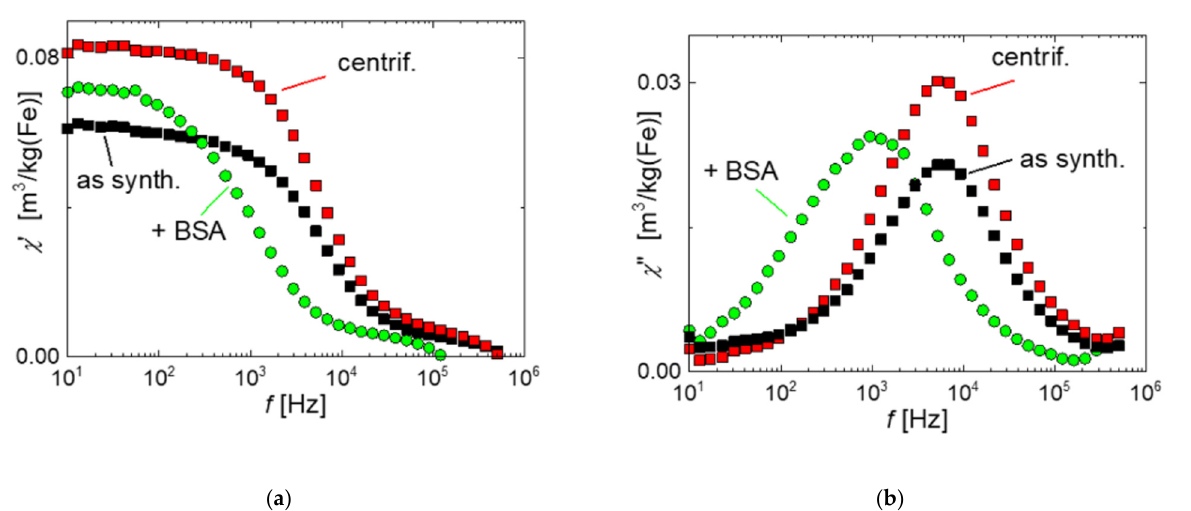
Figure 3. Linear AC susceptibility versus frequency of as-synthesized (black symbols), centrifuged (red symbols), and BSA-coated (green symbols) MNP. ( a ) real part χ ′ , ( b ) imaginary part χ ′′ . While as-synthesized and centrifuged MNP show the same spectra with an increased susceptibility for the centrifuged MNP of about 26%, the BSA-coated MNP show a shift of the χ ′ peak towards lower frequencies due to the increase of hydrodynamic diameter by the additional BSA-layer.